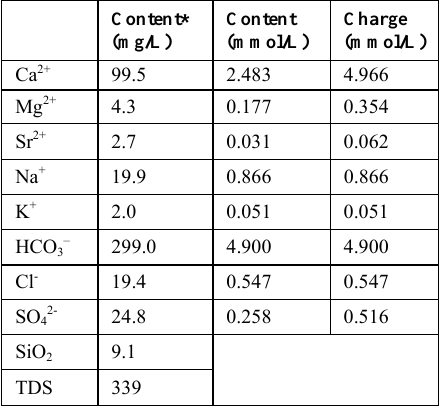
TABLE I. C HEMICAL COMPOSITION OF AN EXAMPLE OF MINERAL WATER (F RASASSI , I TALY ) AND CALCULATIONS OF CONTENT AND CHARGES